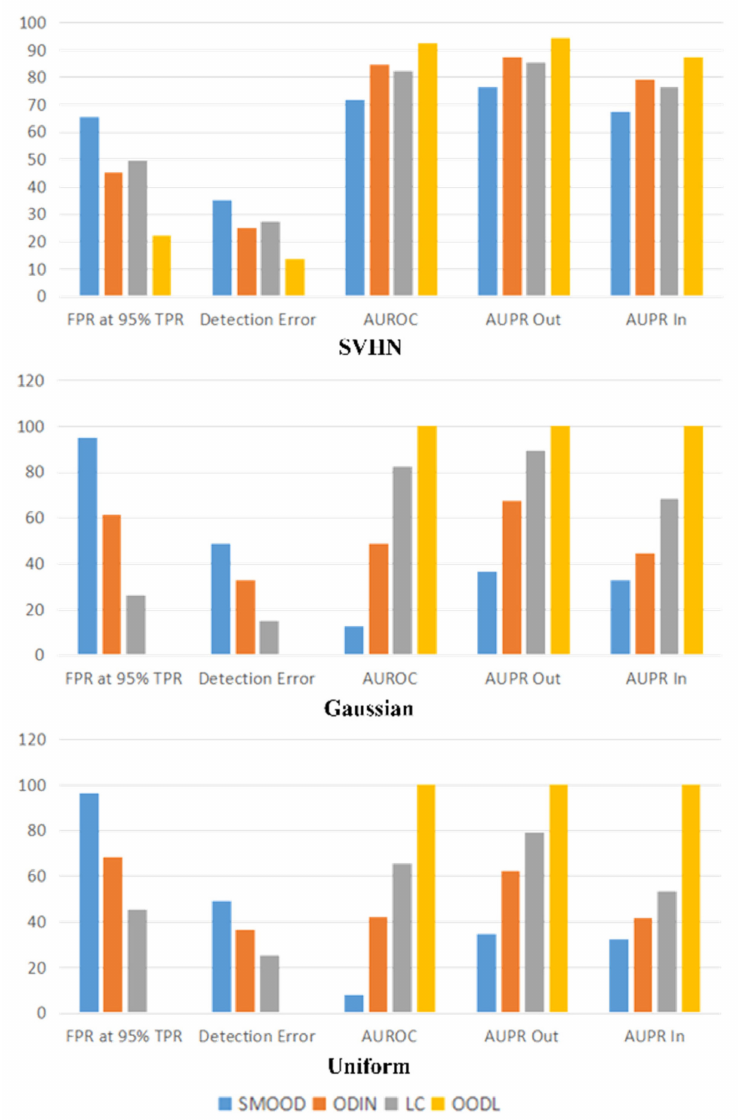
Figure 4. Comparison of results. The ID data are CIFAR-100, the OOD data are SVHN, Gaussian, and Uniform, and the model is VGG16.